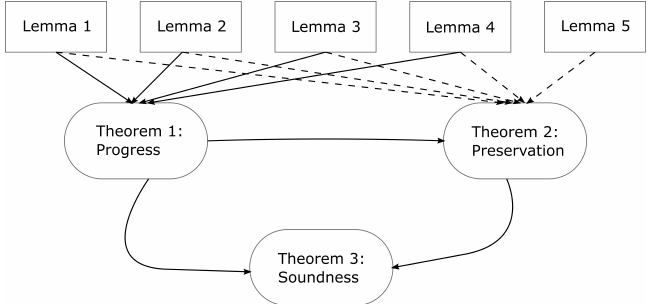
Figure 6. Dependency among proof